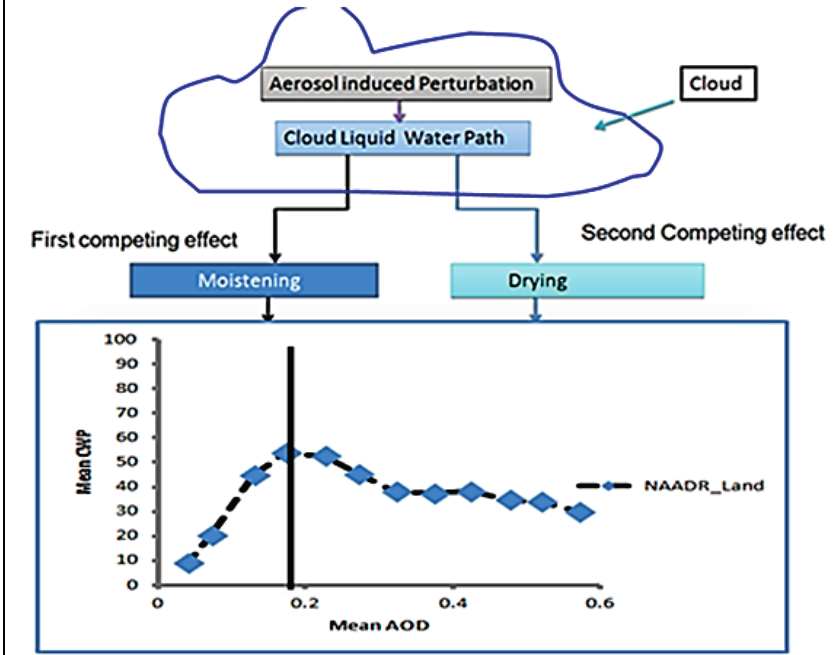
Figure 7. Illustration of cloud and aerosol interaction that resulted in an initial increase (moistening) of cloud water path (CWP) to a maximum followed by a decrease (drying) as aerosol optical depth (AOD) increases for